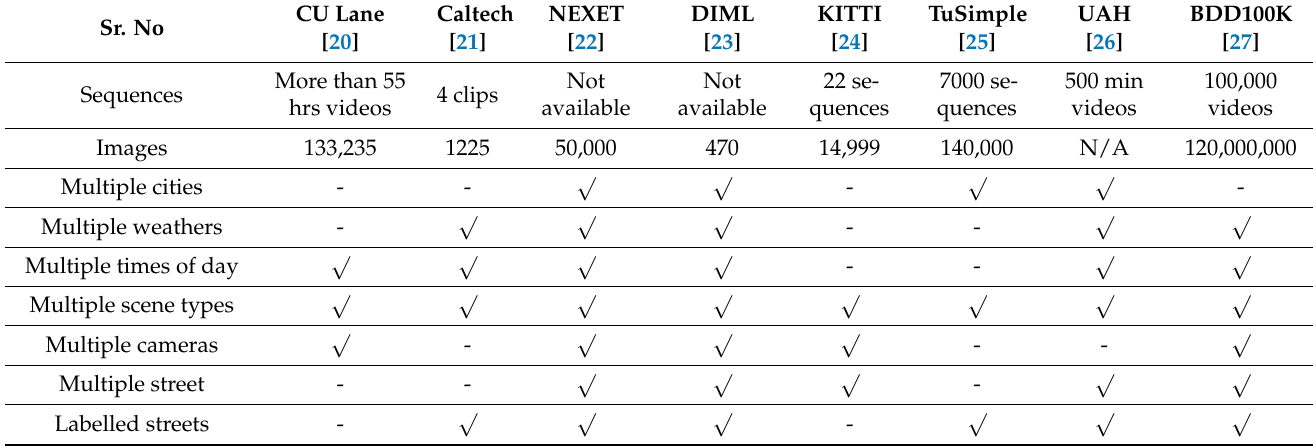
Table 1. Comparison among different lane